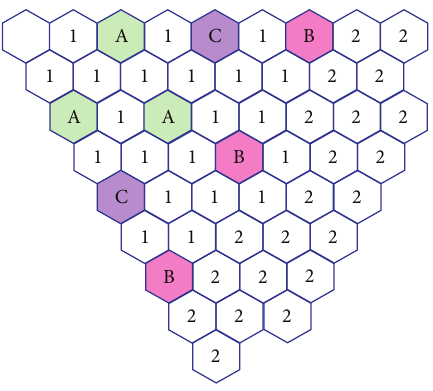
Figure 6: Grouping and Layout of Control